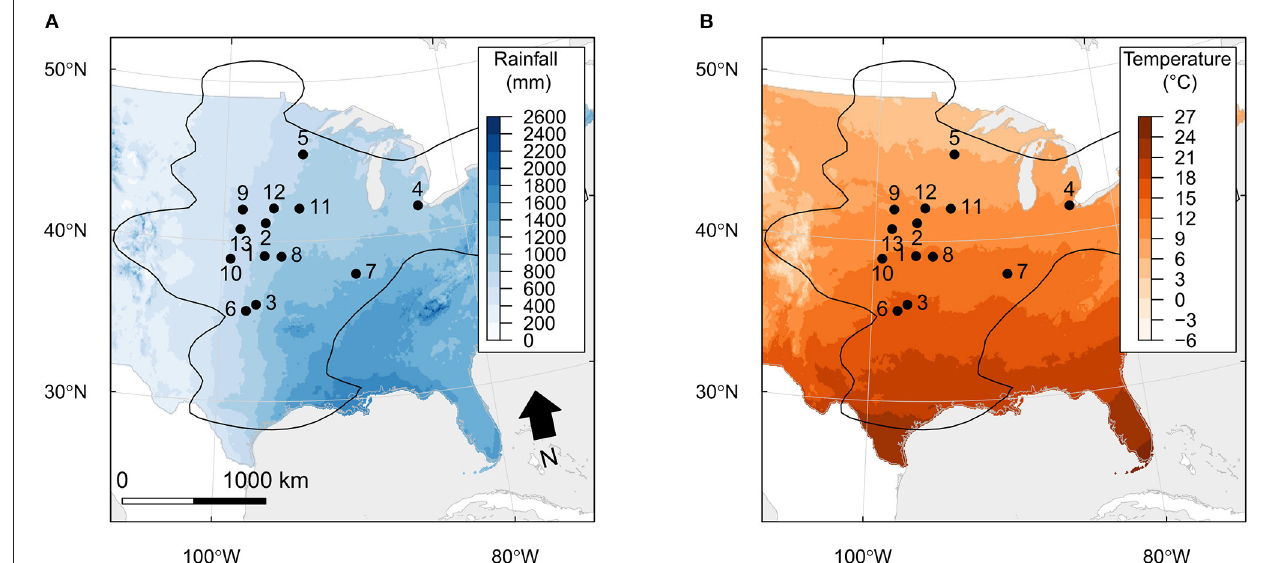
FIGURE 1 | Site locations of gathered A. gerardii functional traits used in this study. The black contour line indicates the 90% percentile of the density of GBIF occurrences. Source ID codes, locations, precipitation (A) , and temperature (B) data are located in the Supplementary Material